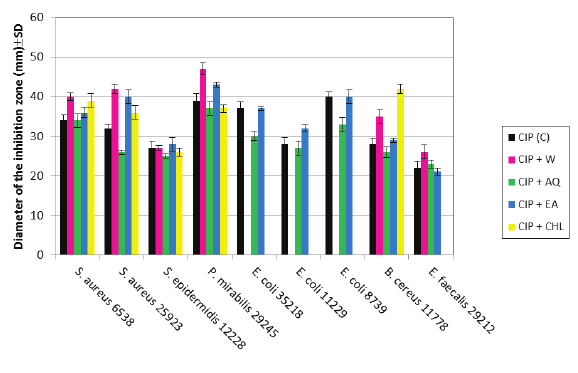
Figure 4: Bacterial strains response to Cyprofl oxacin/CIP combinations with the four Arctii folium extracts (CIP+W, CIP+AQ, CIP+EA, and CIP+CHL) comparatively to the antibiotic alone, CIP (C); diameter of the inhibition zone, (mm) ±